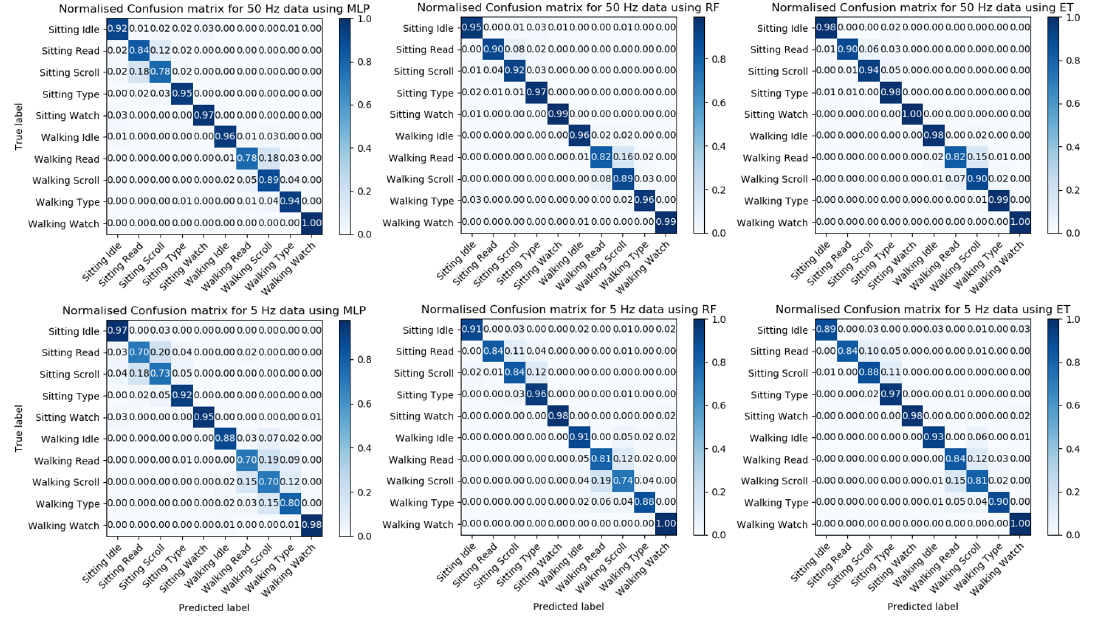
Figure 7. Confusion matrix for the three models (Multi-Layer Perceptron (MLP), Random Forest (RF) and Extremely Randomized Trees (ET)) with different